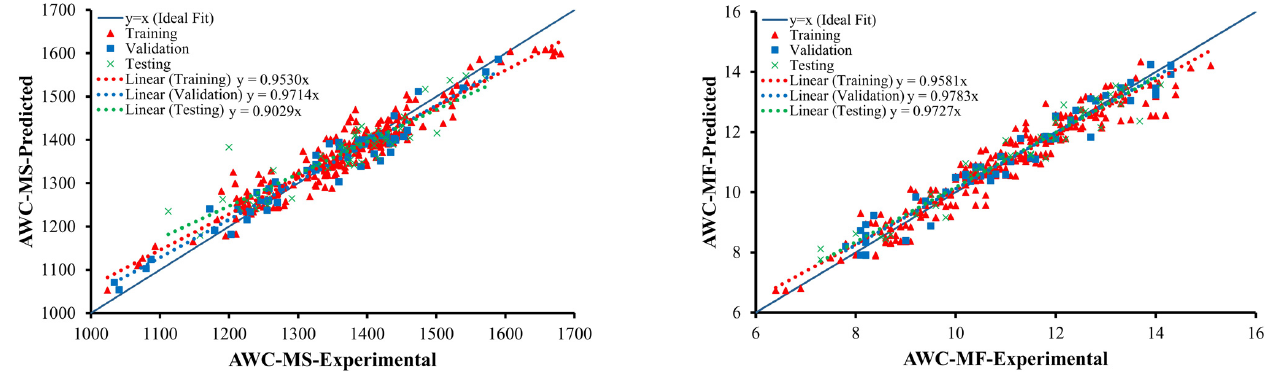
Figure 3. Comparison between experimental and predicted values of ABC.